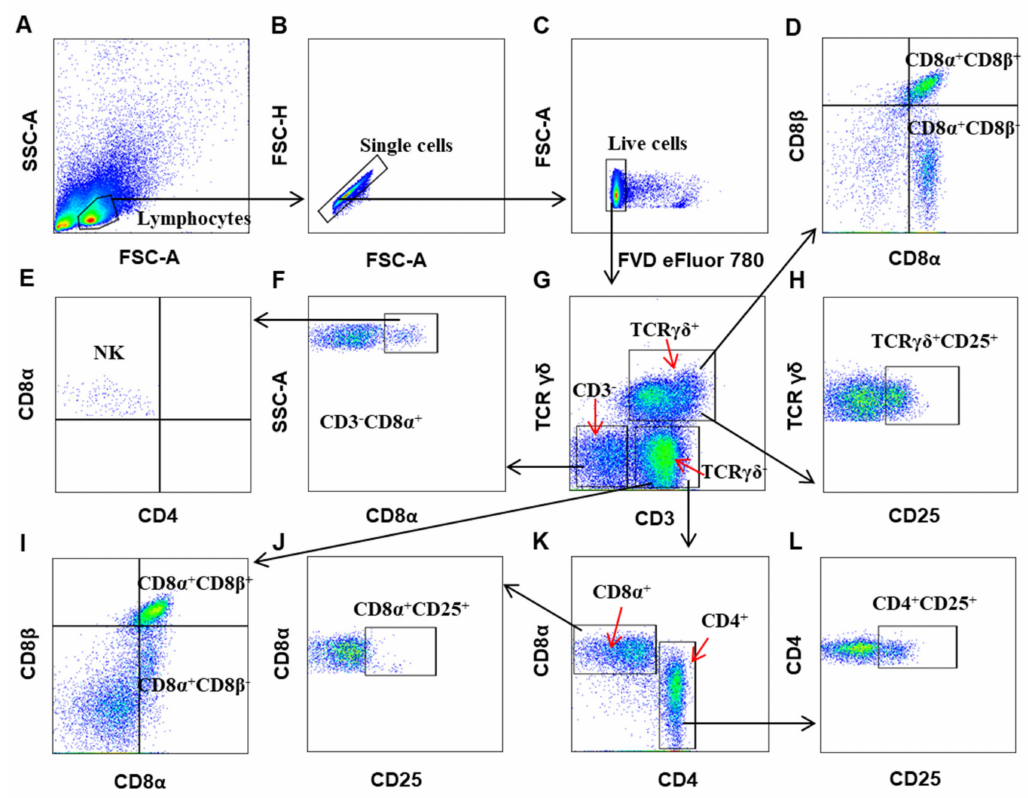
Figure 2. Gating strategies to define chicken T cell subsets, NK cells, and their activation state. Mononuclear cells were isolated from spleens of 4 weeks-old naïve chicken and surface stained with antibody cocktails (Panel 2: CD3, TCR γδ , CD4, CD8 α , CD8 β , CD25, and FVD eFluor 780). The lymphocytes are chosen with FSC versus SSC ( A ), and then single cells were gated using FSC-A and FSC-H ( B ). Live cells were defined as FVD eFluor 780-negative ( C ). By outputting CD3 versus TCR γδ , CD3 + TCR γδ + ( γδ T cells), CD3 + TCR γδ − , and CD3 − TCR γδ − cells were identified, respectively ( G